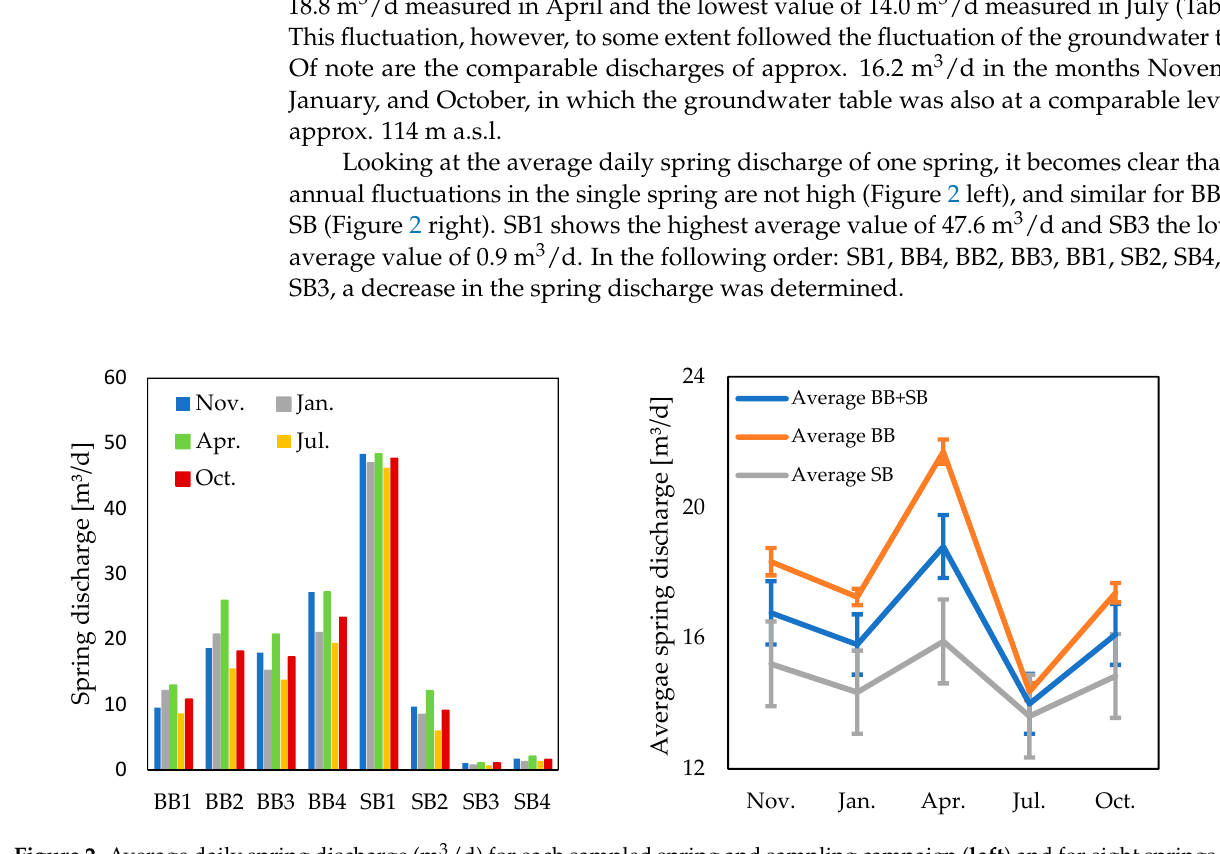
Figure 2. Average daily spring discharge (m 3 /d) for each sampled spring and sampling campaign ( left ) and for eight springs from November 2018 until October 2019 ( right ); vertical error lines represent the ± SD/10 of the respective parameter.